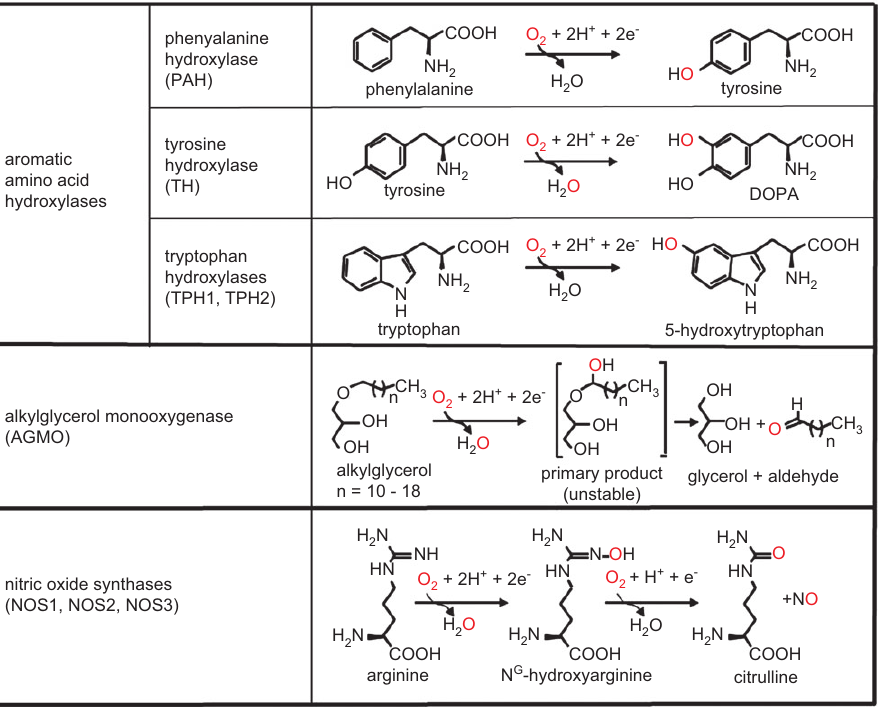
Figure 1 Chemical reactions catalyzed by the three classes of tetrahydrobiopterin-dependent enzymes. The respective gene symbols in humans are in parentheses. The intermediate semiacetal as initial reaction product of the alkylglycerol monooxygenase is assumed to occur by plausibility, an experimental proof of it as well as knowledge on whether or not its rearrangement is assisted by an additional enzyme is currently missing. The figure was modified from Ref. [ 1